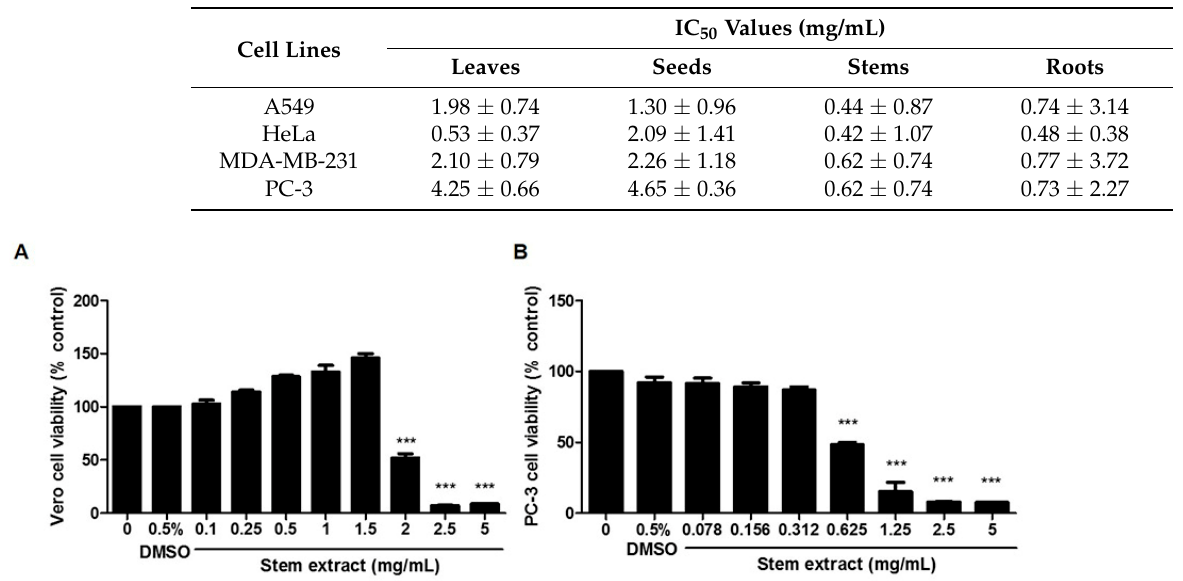
Figure 1. Dose-dependent inhibitory effects of an MC stem extract on the viability of ( A ) Vero and ( B ) PC-3 cells. Cells were treated with various concentrations (0–5 mg/mL) for 24 h. Data are presented as the mean of triplicate values ± SEM. *** indicates p < 0.001. Table 1. The antiproliferative effect of MC extracts were determined by MTT assays. All cells were treated with or without the different parts (leaves, seeds, stems, and roots) of extracts (0–5 mg/mL) for 24 h. Control cells were exposed to vehicle or 0.5% DMSO. The data are offered as the mean of triplicate values ± SEM.